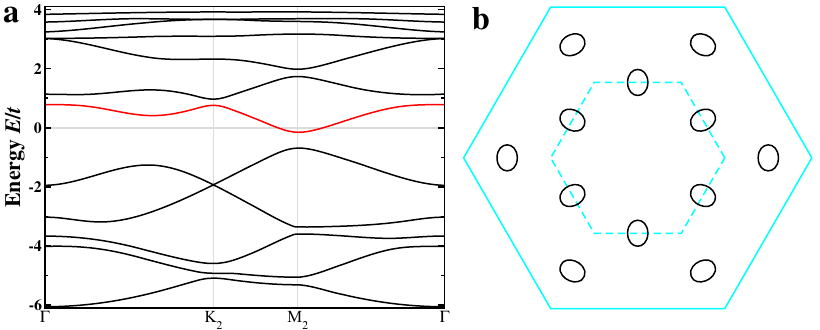
Fig. 5 | Complex CDW in t - V 1 - V 2 model. Band dispersion ( a ) in the 2×2 reduced BZ and the corresponding Chern FS pockets ( b